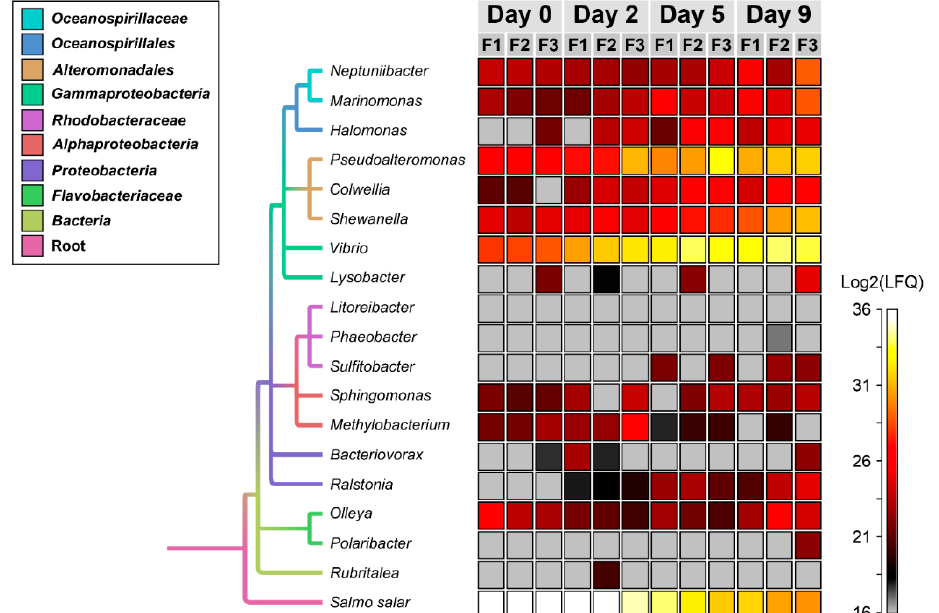
Figure 3. Heat map of the total expressed proteins. The heat map shows the abundances of expressed proteins, summarized at genus level, during 9 days of mucus incubation with sterilized seawater. It ranges from low abundance (gray), to medium abundance (red) and high abundance (white). The genera are sorted based on a phylogenetic tree made with the NCBI Common Tree tool and visualized using the software FigTree version 1.4.